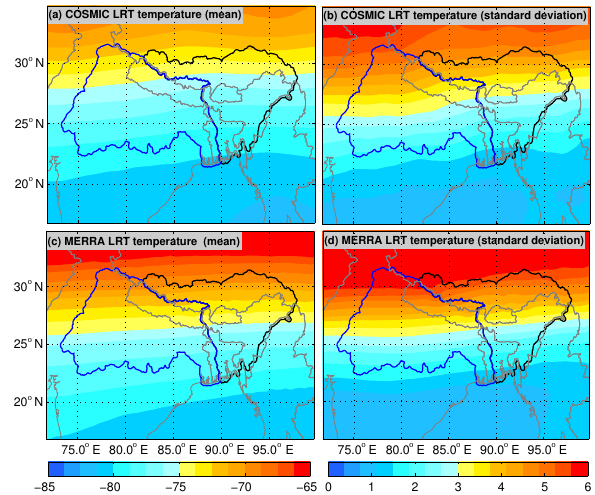
Figure 8. Spatial variation of mean and standard deviation of tropopause temperatures ( ◦ C) derived from COSMIC RO and MERRA product based on 89 months from August 2006 to De- cember 2013. (a) Mean and (b) standard deviation of tropopause temperatures ( ◦ C) from COSMIC RO; (c) mean and (d) standard deviation of tropopause temperatures ( ◦ C) from MERRA product.